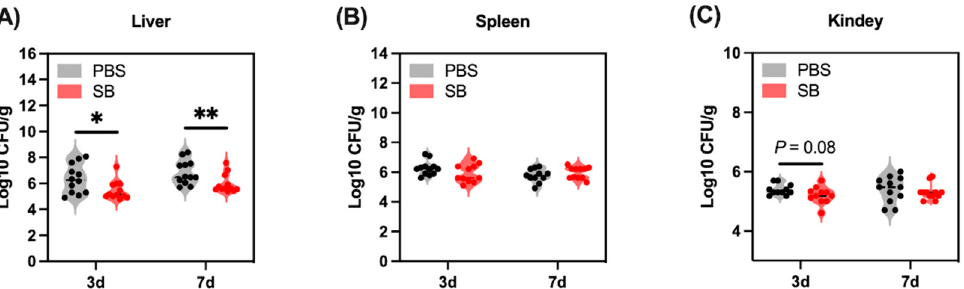
Figure 9. Effects of S. boulardii early intervention on the translocation of bacteria. Bacteria load in the liver ( A ), spleen ( B ), and kidney ( C ). Values are expressed as means ± SEM, n = 10–12. * p < 0.05, ** p < 0.01. d, day. PBS, rats early intervened with phosphate buffer solution. SB, rats early intervened with S. boulardii .